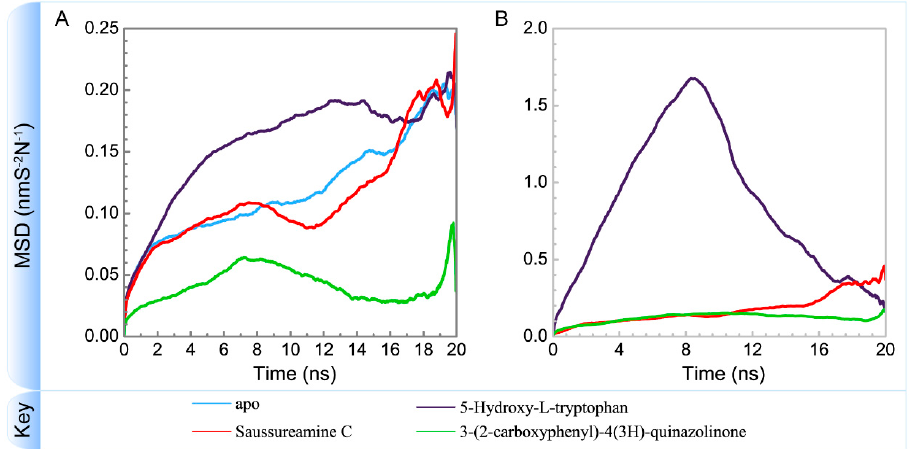
Figure 17. Variation of mean square displacements of ( A ) protein and ( B ) ligand over 20 ns for paraplegin in apo form and in complexes with three TCM candidates.